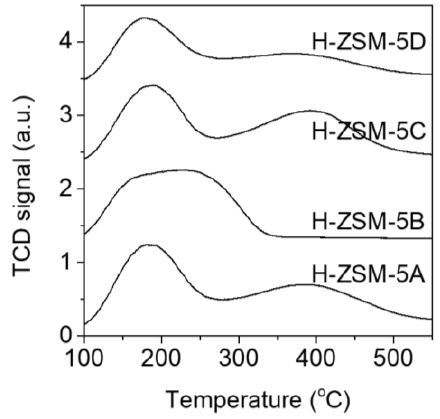
Figure 3. NH 3 TPD curves of H-ZSM-5A, H-ZSM-5B, H-ZSM-5C, and H-ZSM-5D.